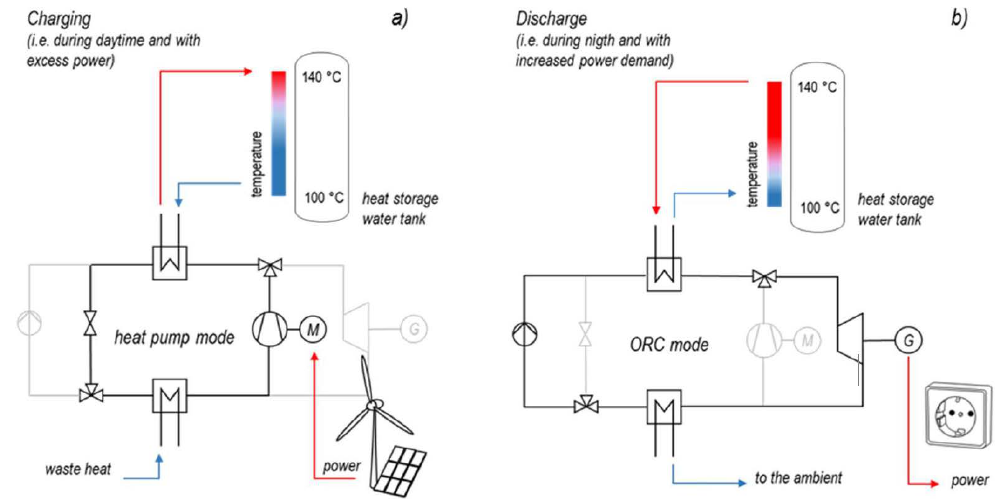
Figure 2. System setup for the reversible HP / ORC storage system during: ( a ) charging and ( b ) discharging